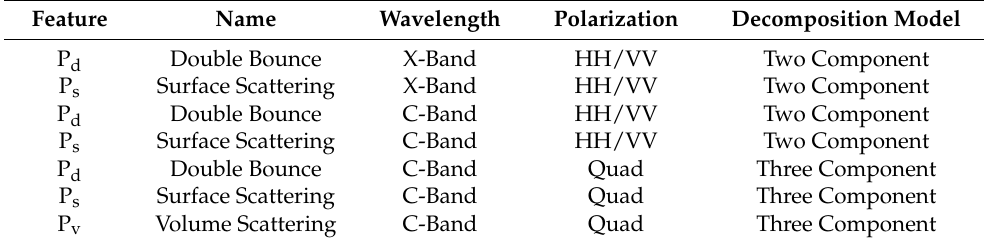
Table 3. Decomposition features examined in the correlation, regression, and separability analysis.